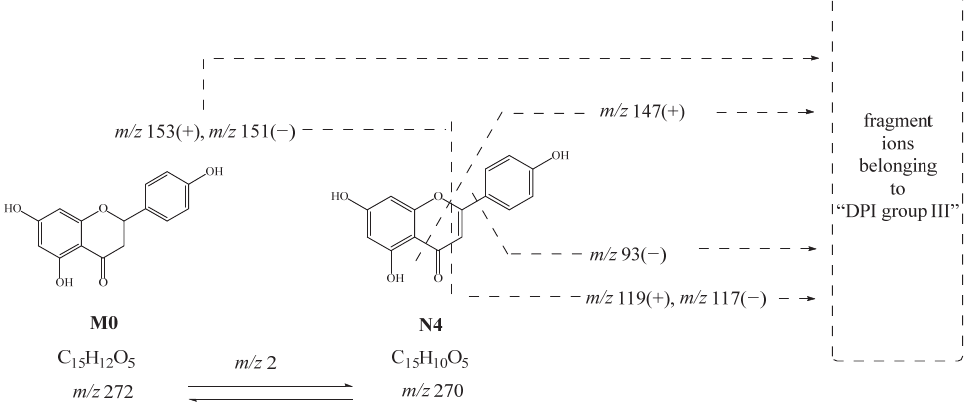
Figure 4. Possible cleavage pathway of N4 .